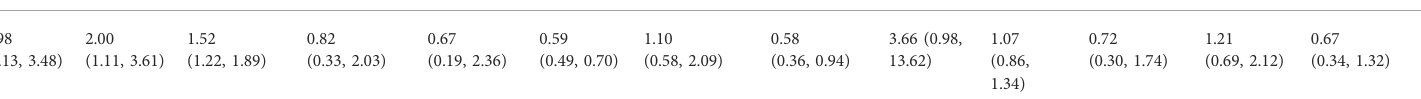
TABLE 2 ( Continued ) The results of network meta-analysis for all pairwise comparisons. (A) Overall abstinence